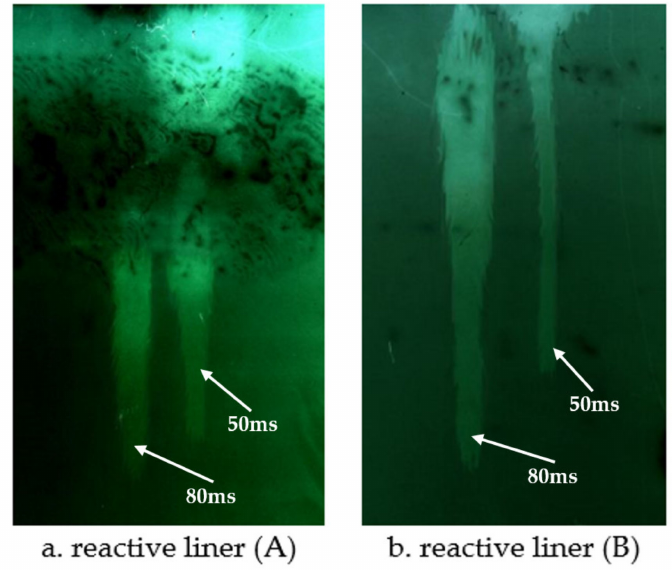
Figure 8. Experimental results of pulsed X-ray for reactive liner ( a ) A and ( b )